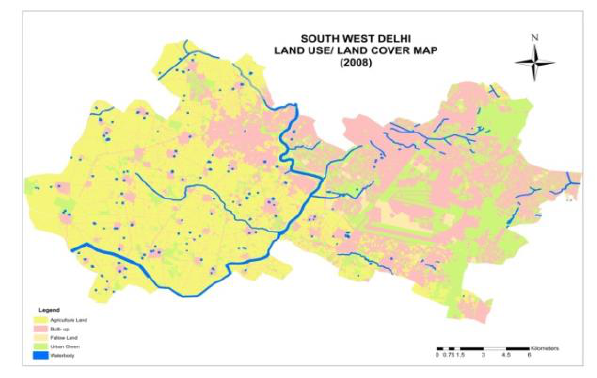
Figure 3: Land Use/ Land Cover Map 2008